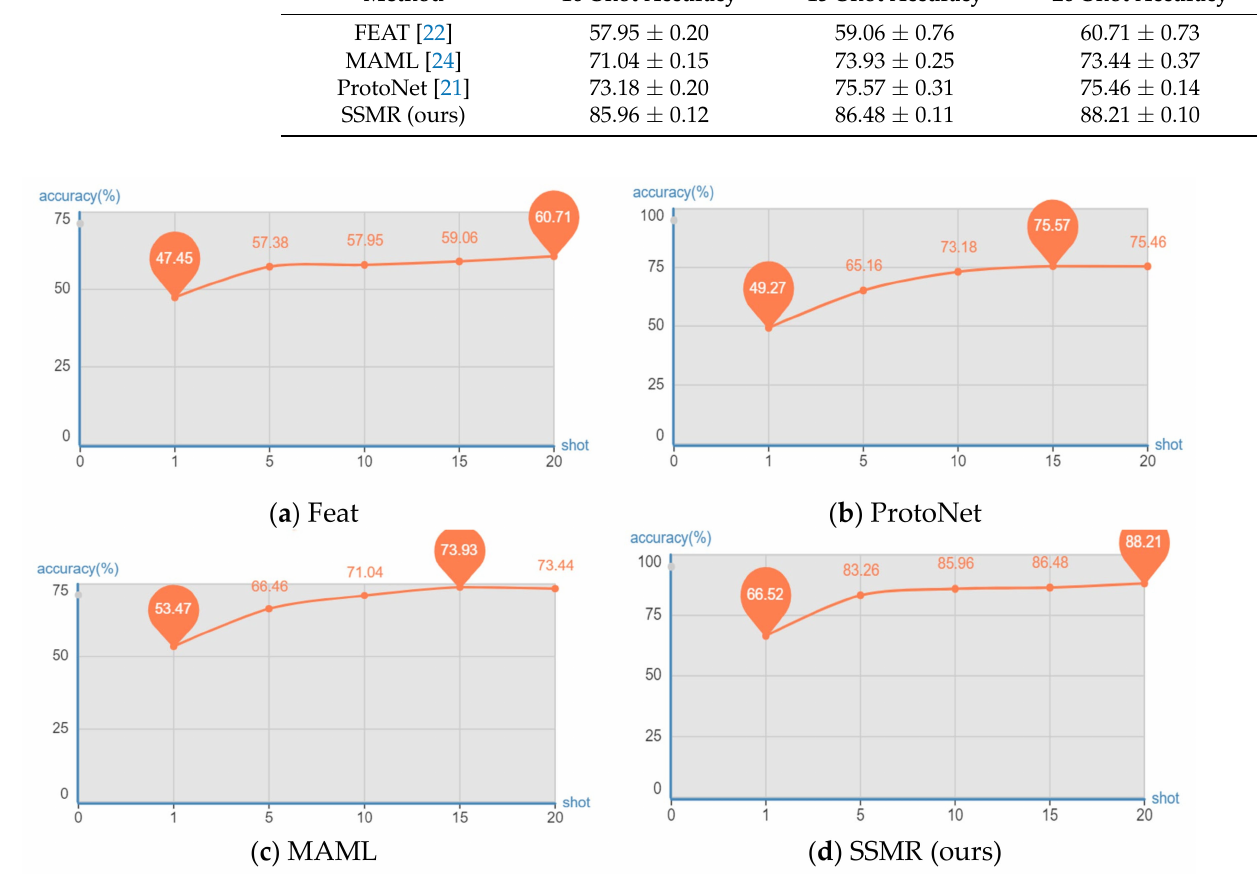
Figure 6. The effects of shot numbers on the test performances of different methods are reported with 95% confidence